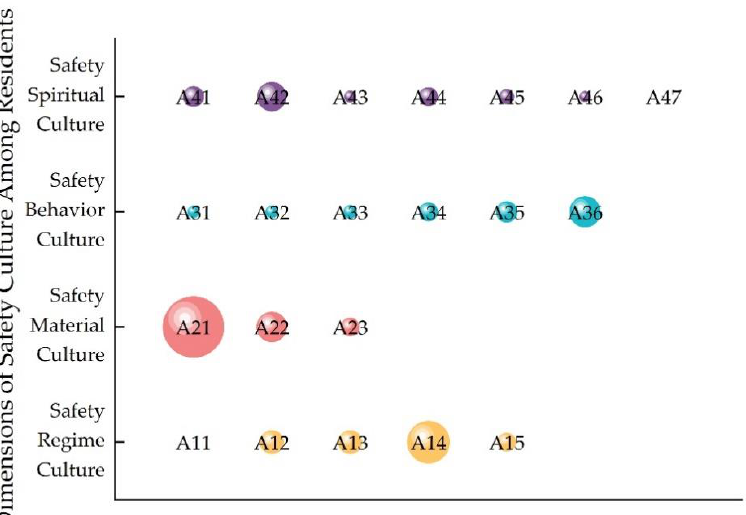
Figure 11. The main obstacle factors of safety culture among residents during COVID-19.